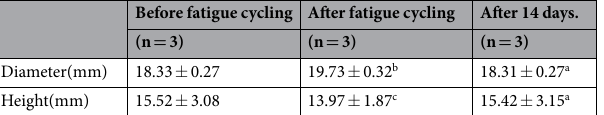
Before fatigue cycling After fatigue cycling After 14 days.